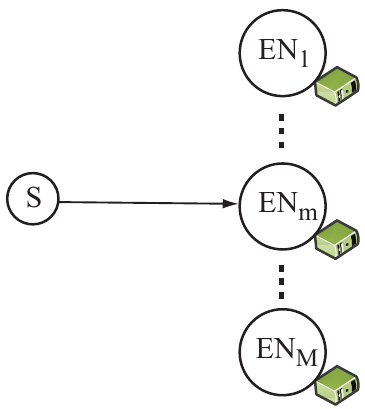
Figure 1. System model of a MEC network with multiple